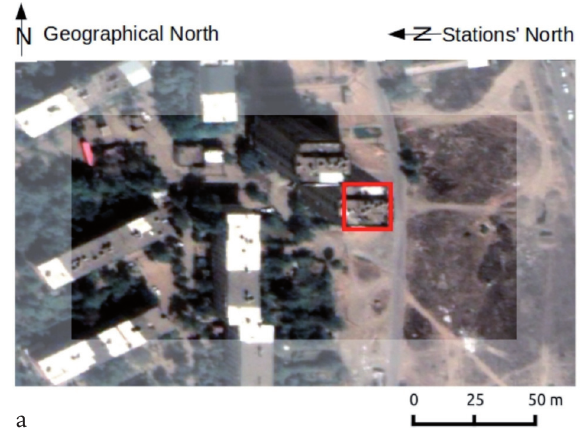
Figure 3. (a) Satellite image and (b) building floor plan of the 12 story monolitic RC building (Figure 2,I), showing the locations of the installed stations (red